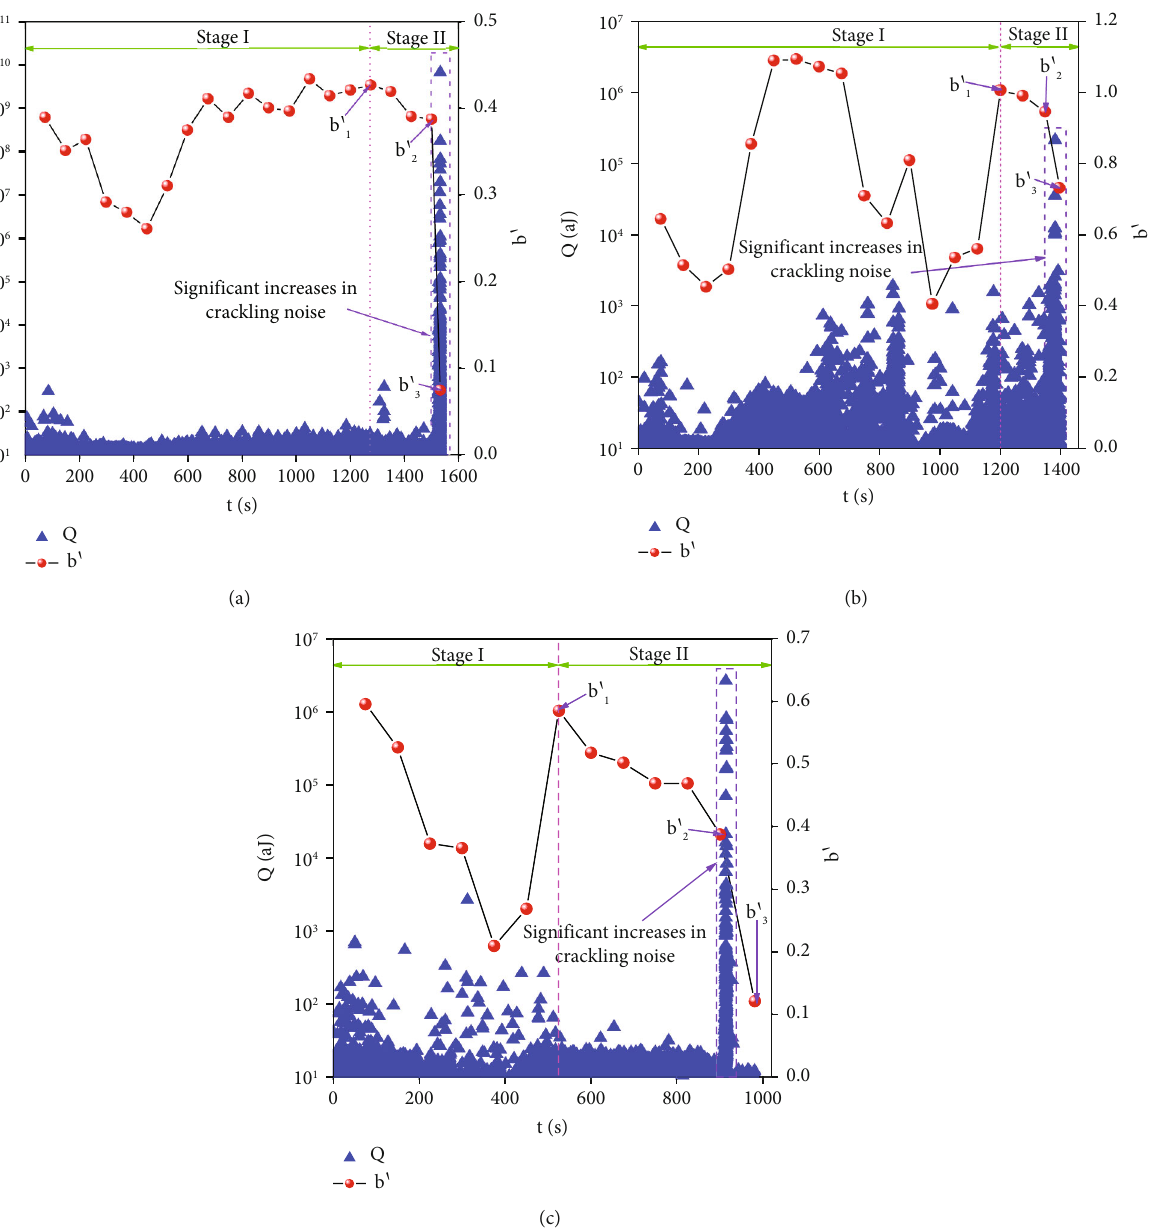
Figure 5: Estimated value of b and the acoustic emission energy versus time evolutions for the specimens: (a) A-1; (b) B-1; (c)